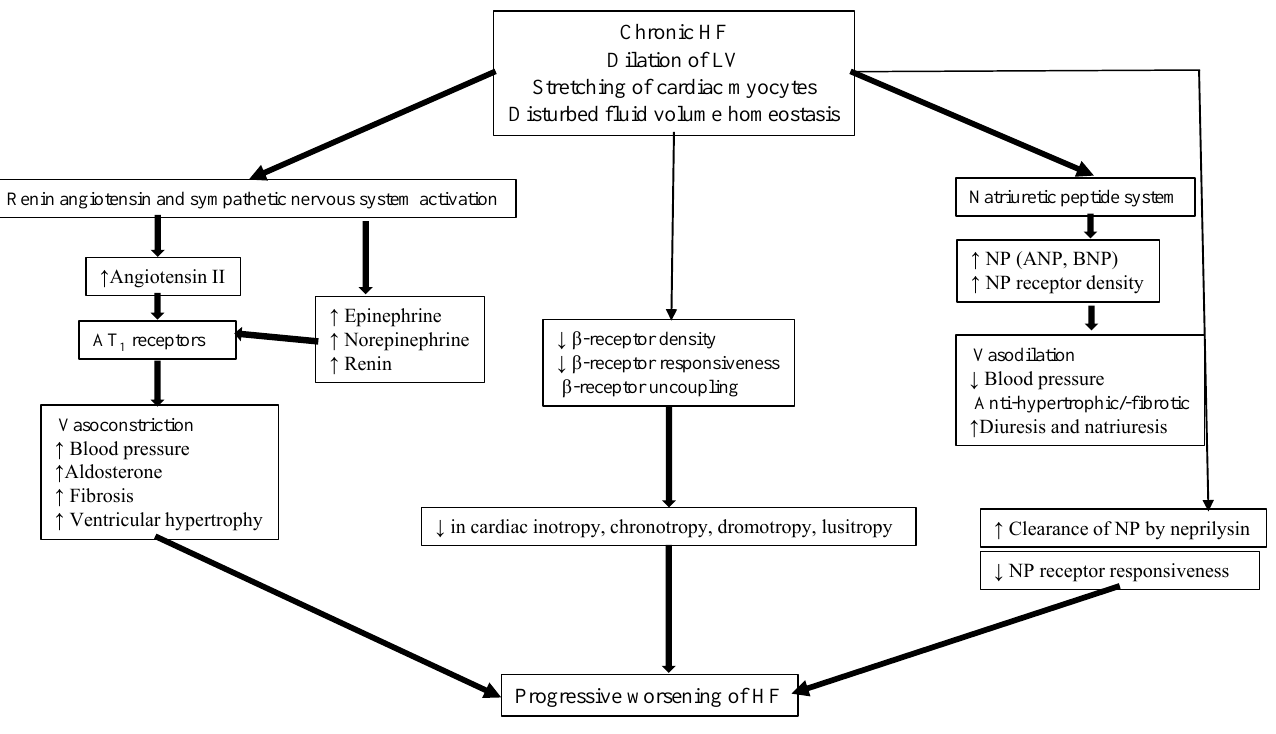
Figure 2. Pathophysiology of chronic HF. (LV: left ventricle; AT1: angiotensin 1; NP: natriuretic peptide; ANP: atrial natriuretic peptide; BNP: B-type natriuretic